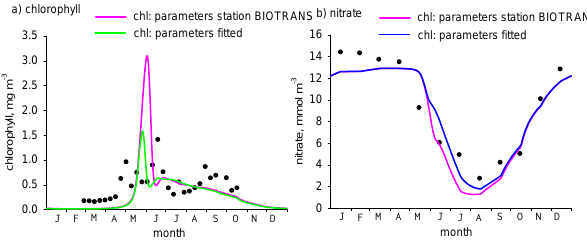
Figure 13. Simulations for station India: (a) chlorophyll, (b) nitrate. Data are for year